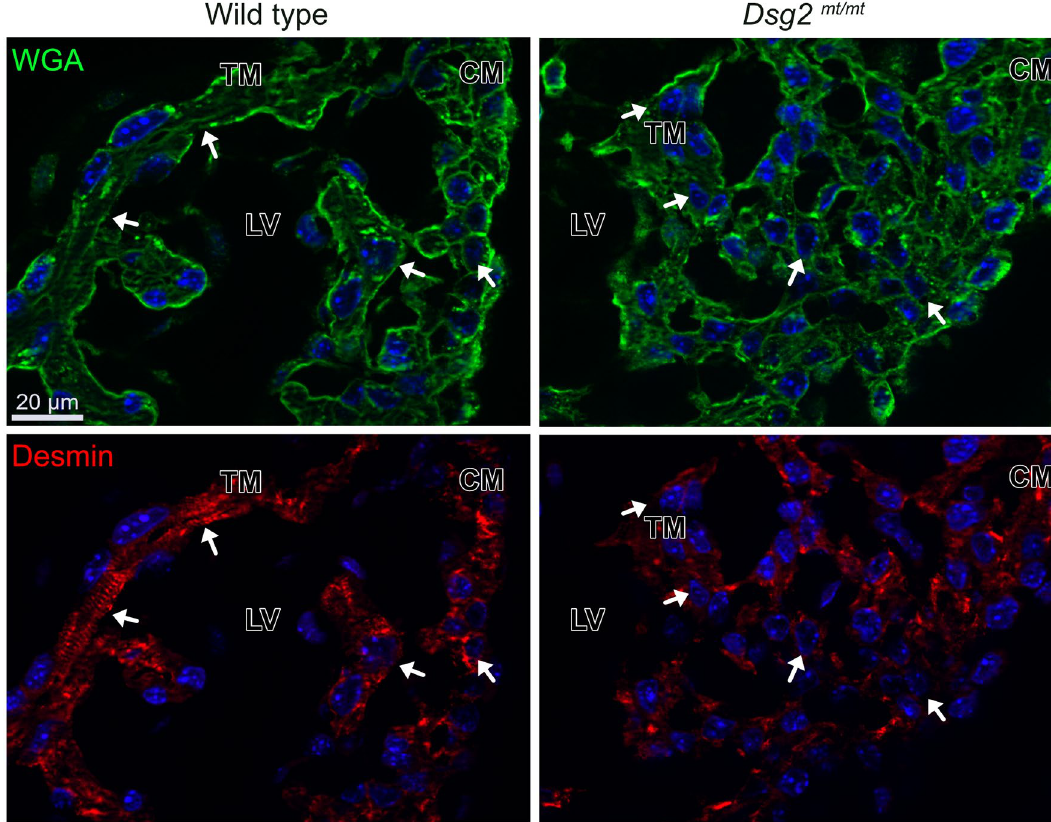
Figure 8. The shape and desmin cytoskeleton of cardiomyocytes is altered in Dsg2 mt/mt myocardium prior to the formation of abnormal cell clusters at E10.5. The double fluorescence microscopy images depict cell borders, that are delineated by fluorescent wheat germ agglutinin (WGA; green), and the desmin cytoskeleton, which is detected by anti-desmin immunofluorescence (red). Arrows in Dsg2 mt/mt point to reduced desmin expression in compact myocardium and loss of sarcomeric distribution in trabecula (compare to white arrows pointing to CM and TM in wild type). LV, left ventricle; TM, trabecular myocardium; CM; compact myocardium. Data are representative images of n = 3–4 hearts per group. Size bar: 20 μm (same magnification in all